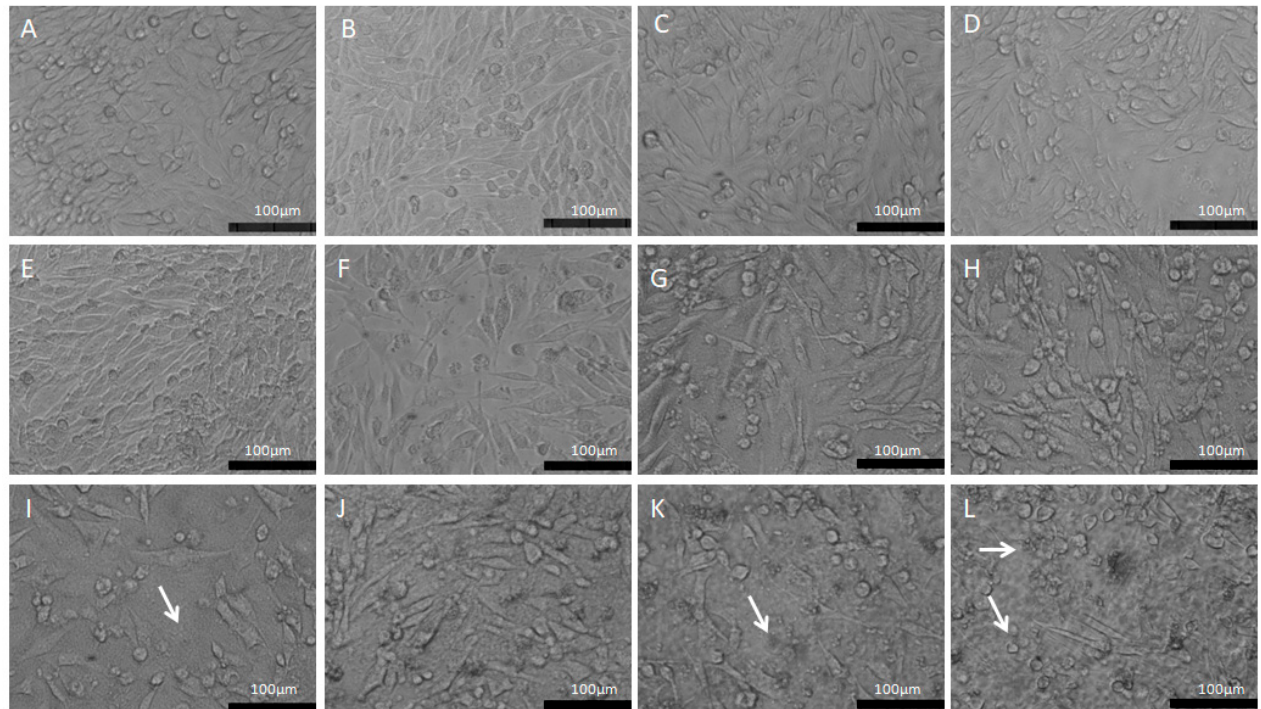
Figure 6. Morphological aspects of the PC12 line exposed to CP in conventional liposomes (0.2–30 μ g/mL). ( A )—Control: PC12 in DMEM medium; ( B )—PC12 in DMEM medium treated with 0.5% empty liposomes. ( C )—PC12 in DMEM with 0.2 μ g/mL; ( D )—PC12 in DMEM with 0.3 μ g/mL; ( E )—PC12 in DMEM with 0.6 μ g/mL; ( F )—PC12 in DMEM with 1 μ g/mL; ( G )—PC12 in DMEM with 2 μ g/mL; ( H )—PC12 in DMEM with 3 μ g/mL; ( I )—PC12 in DMEM with 6 μ g/mL; ( J )—PC12 in DMEM with 10 μ g/mL; ( K )—PC12 in DMEM with 20 μ g/mL; ( L )—PC12 in DMEM with 30 μ g/mL. The white arrows represent cell fragments. Phase contrast microscopy, bar equivalent to 100 μ m.